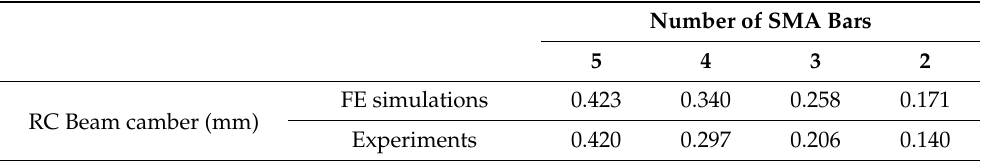
Table 1. RC beam cambers due to activation of Fe-SMA measured by experiments [31] and calculated by FE simulations.